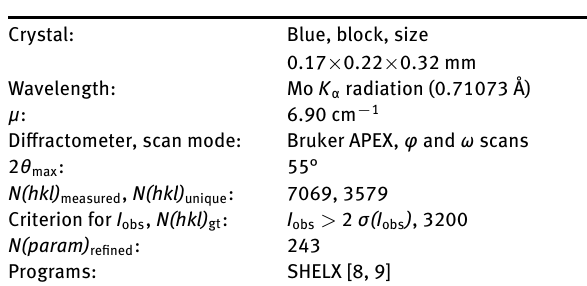
Table 1: Data collection and handling.